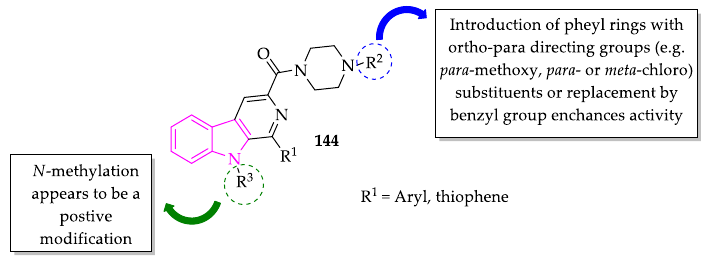
Figure 18. General structure of piperazinyl- β -carboline-carboxamides with antileishmanial activ- ity.